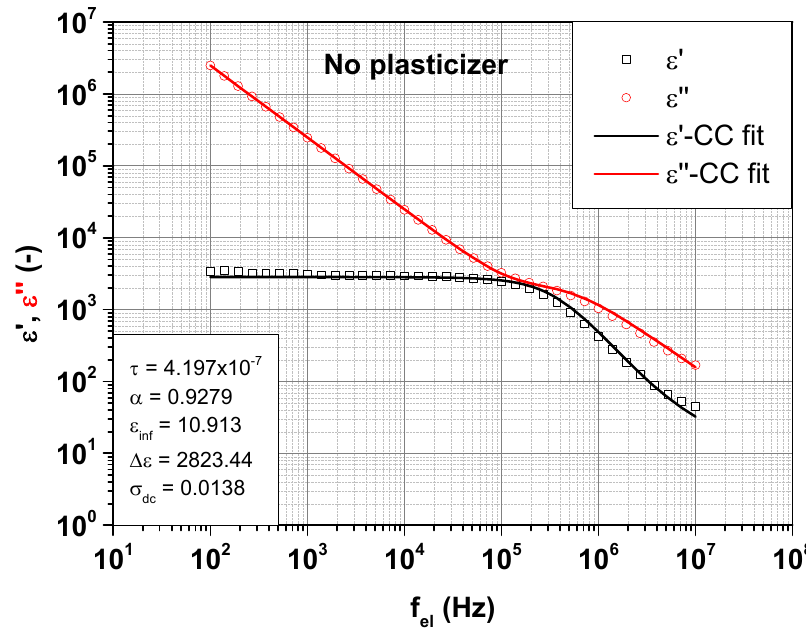
Figure 8. Simultaneous Cole–Cole fitting of real and imaginary part of the permittivity 𝜀 (cid:4593) and 𝜀 (cid:4593)(cid:4593) of SBR sample filled with 20 phr MES at 24 °C under a static force of 10 N.